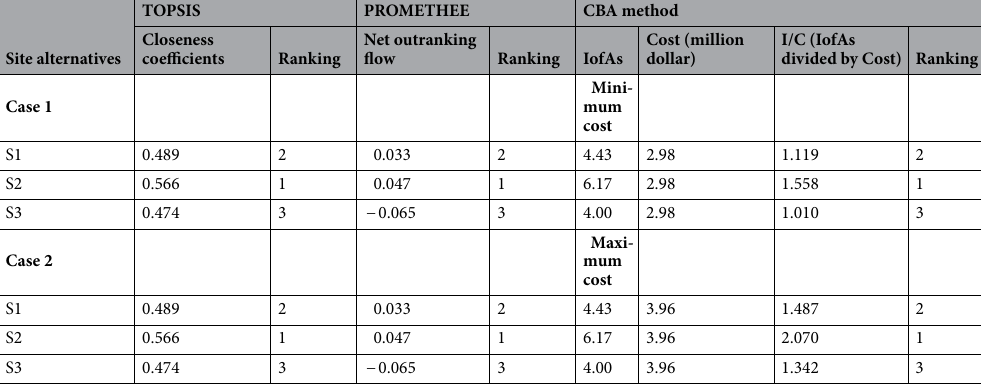
Table 6. The final ranking of the TOPSIS, PROMETHEE, and CBA methods (when all costs are the minimum or maximum cost of the site